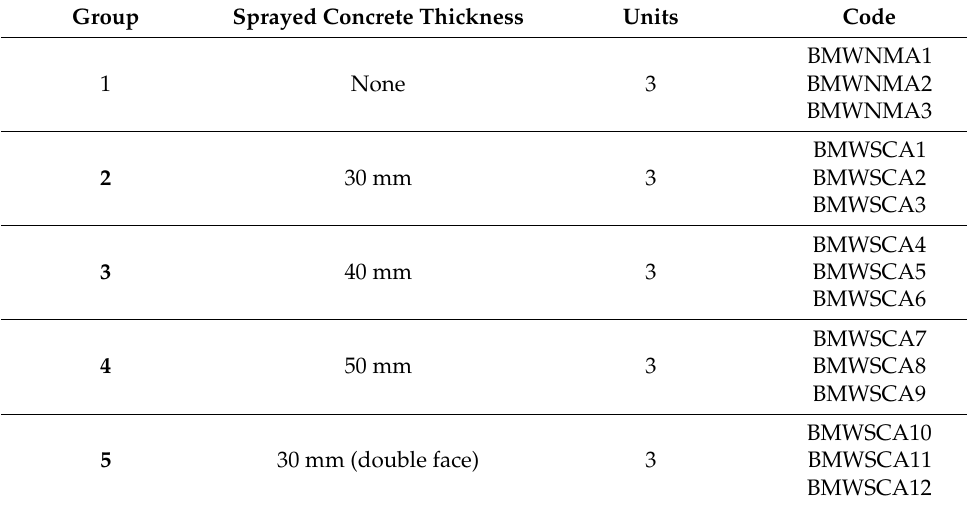
Table 2. Summary of the five types of masonry samples.